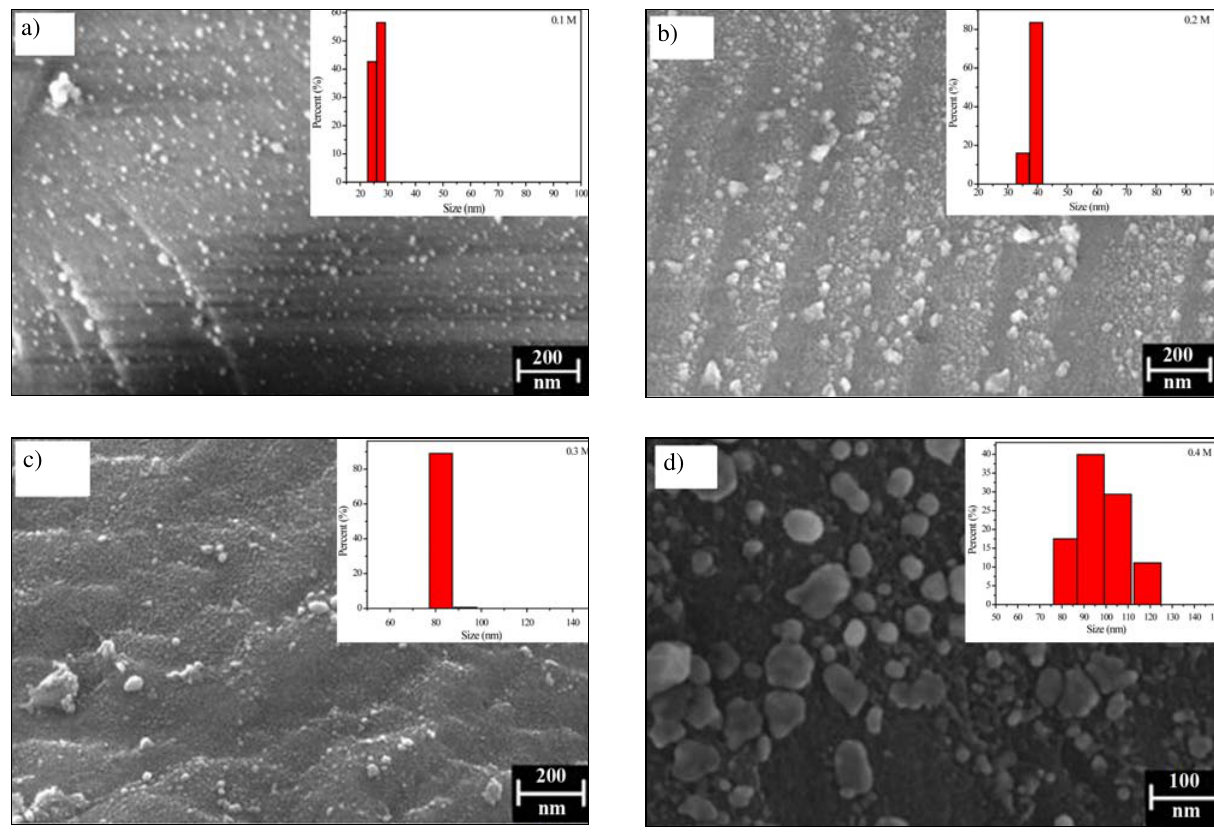
Fig. 2. Microphotographs of the particles obtained from ammonia-alcoholic solutions of different concentration: a) 0.1 M, b) 0.2 M, c) 0.3 M, d) 0.4 M. Size distribution obtained with dynamic light scattering is presented in inset